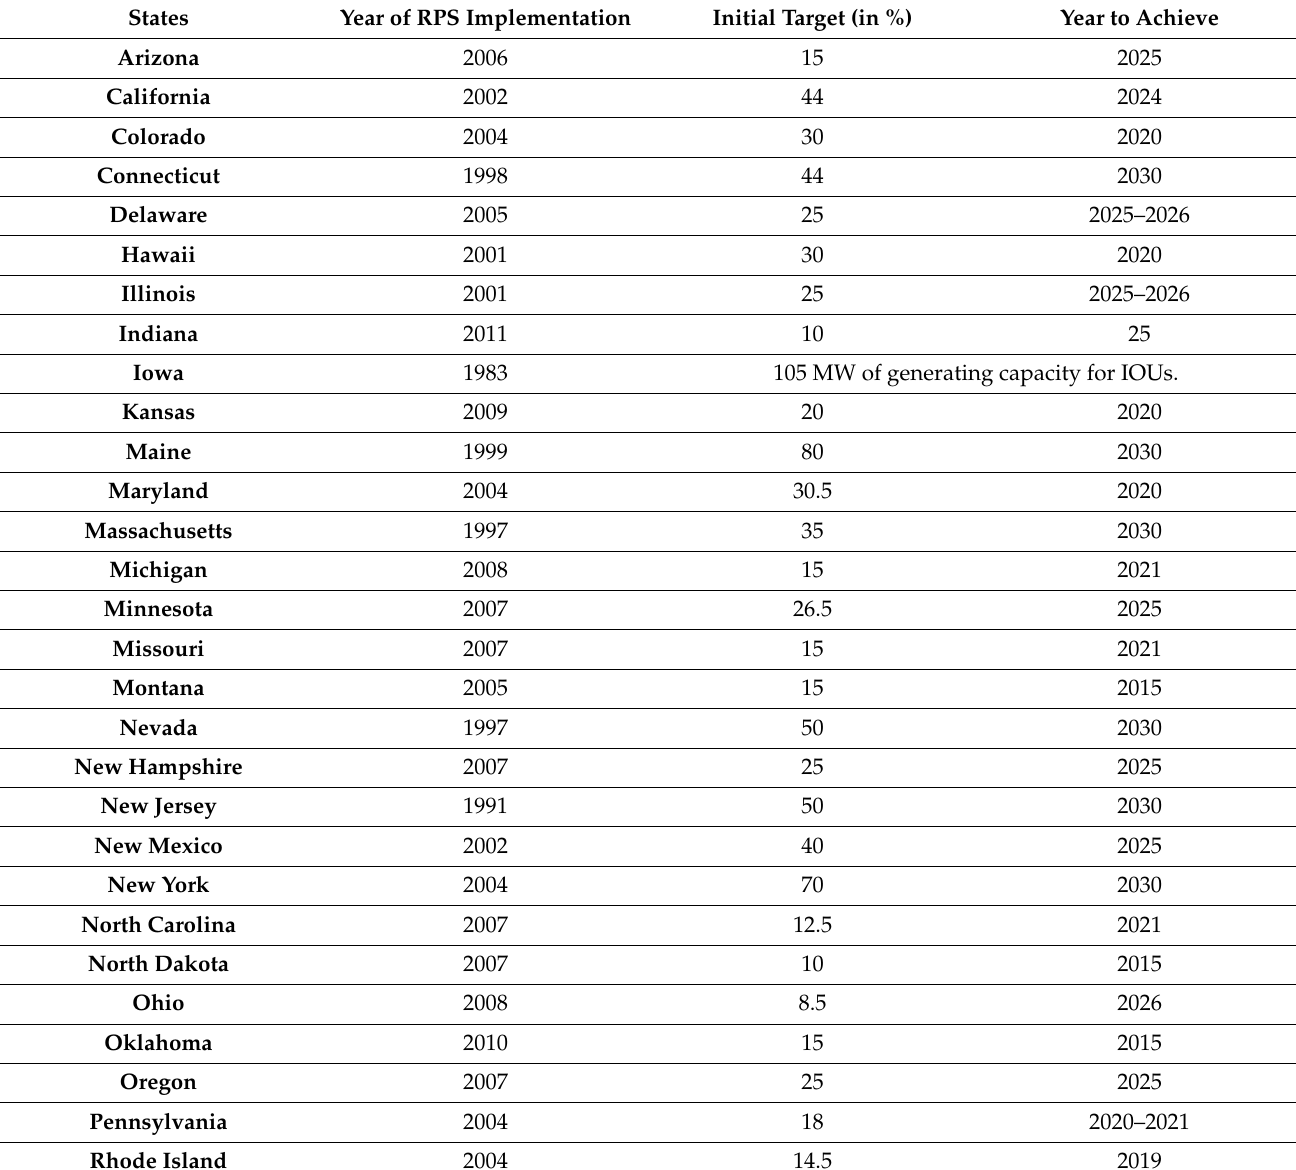
Table A1. State RPS targets in the